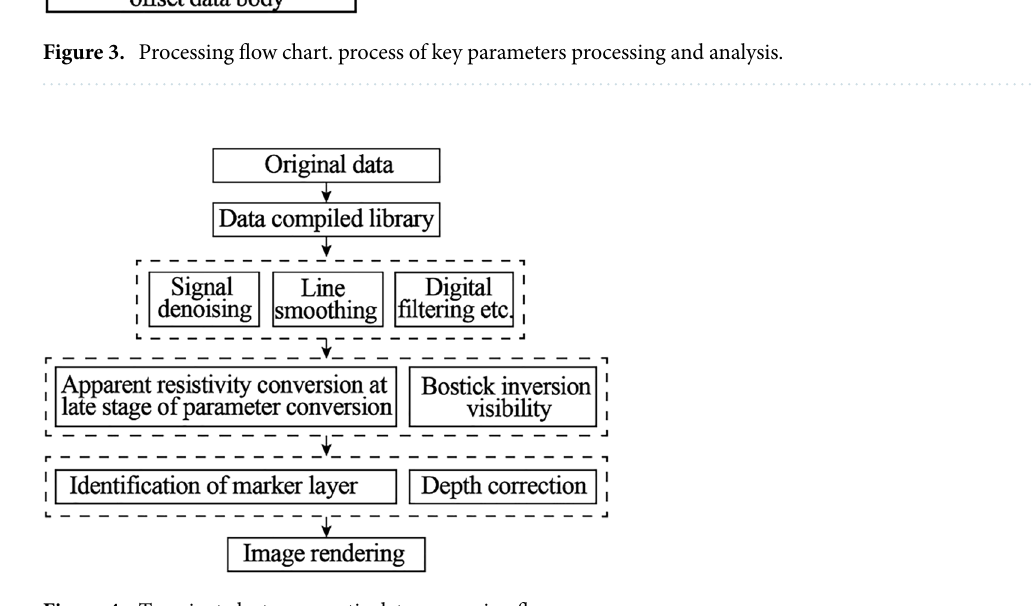
Figure 4. Transient electromagnetic data processing